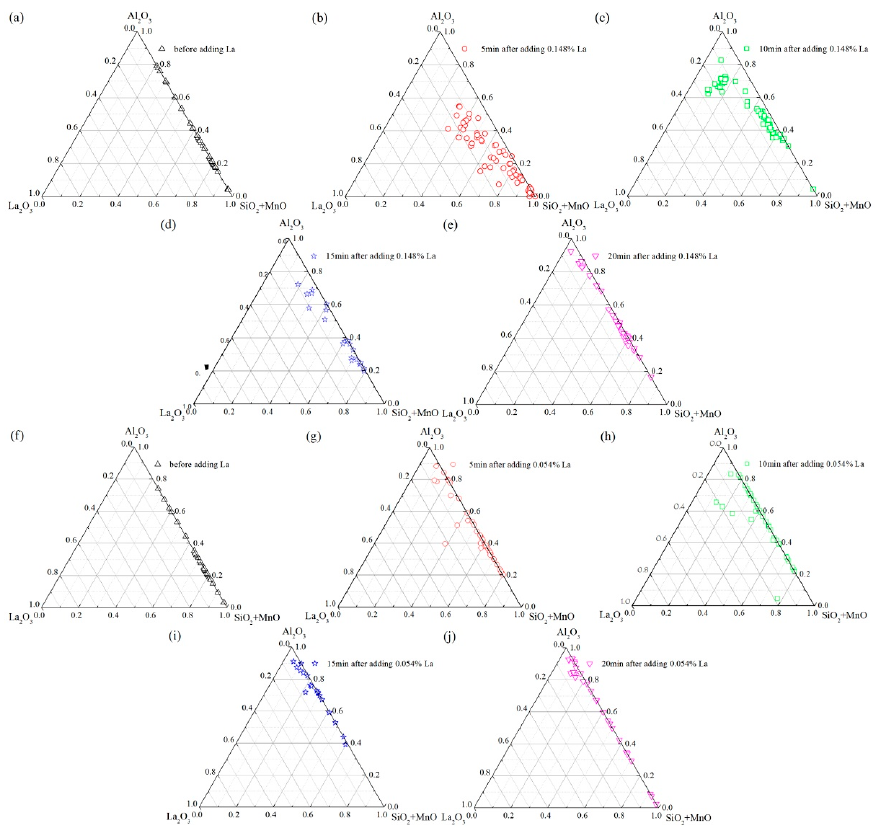
Figure 2. Evolution of inclusions in molten steel. ( a – e ) With the initial La addition of 0.148%; ( f – j ) with the initial La addition of